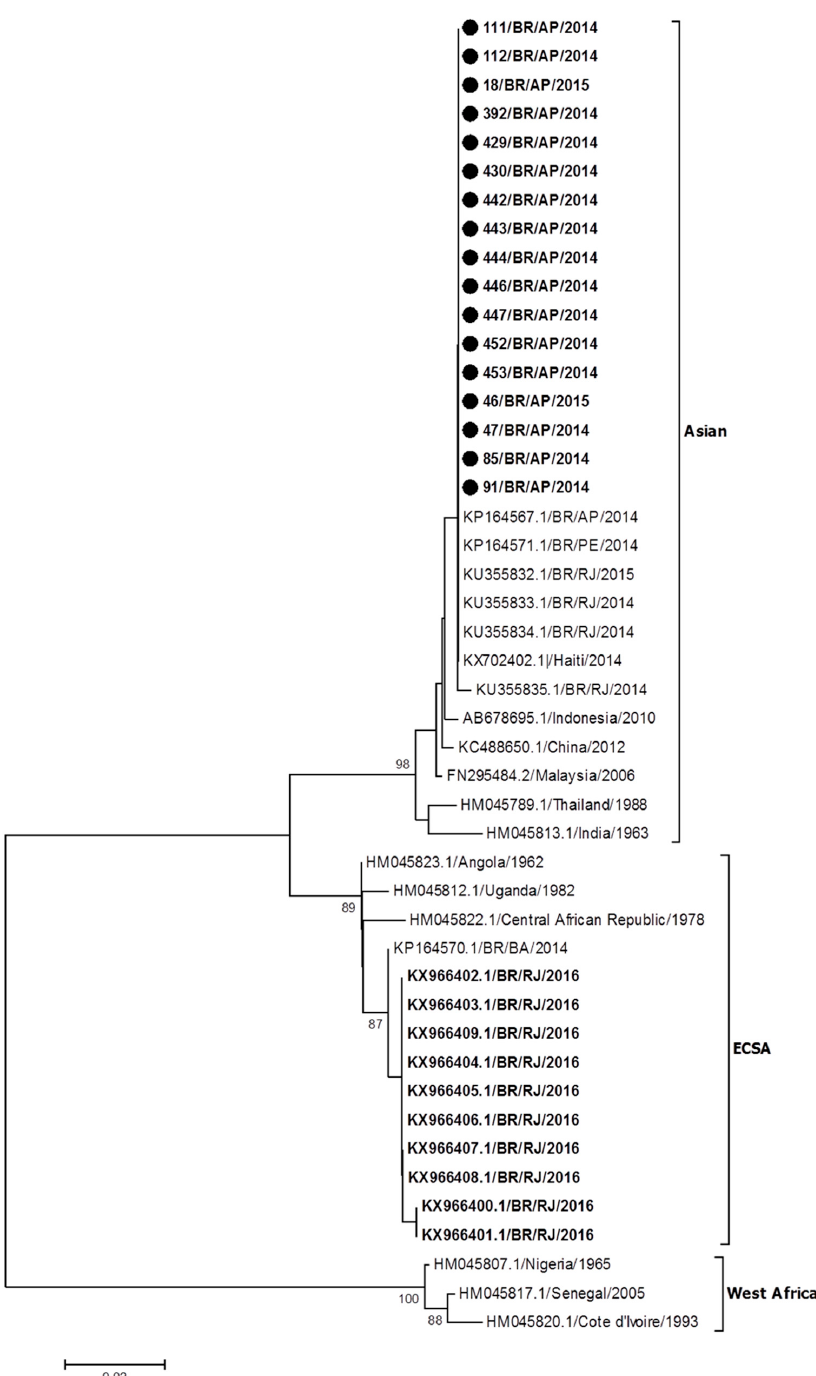
Figure 1. Phylogenetic analysis based on 375 nucleotides recovered from the E1 gene of CHIKV strains identified in Rio de Janeiro ( n = 10) during 2016 and in Amapa ( n = 17). Neighbor-joining method, Kimura-2-parameter model (K2), bootstrap of 1000 repetitions. The analyzed CHIKV sequences are represented by a black circle. The CHIKV strains were designated as follows: GenBank accession number (or strain name/country/year). ECSA: East-Central-South African genotype.